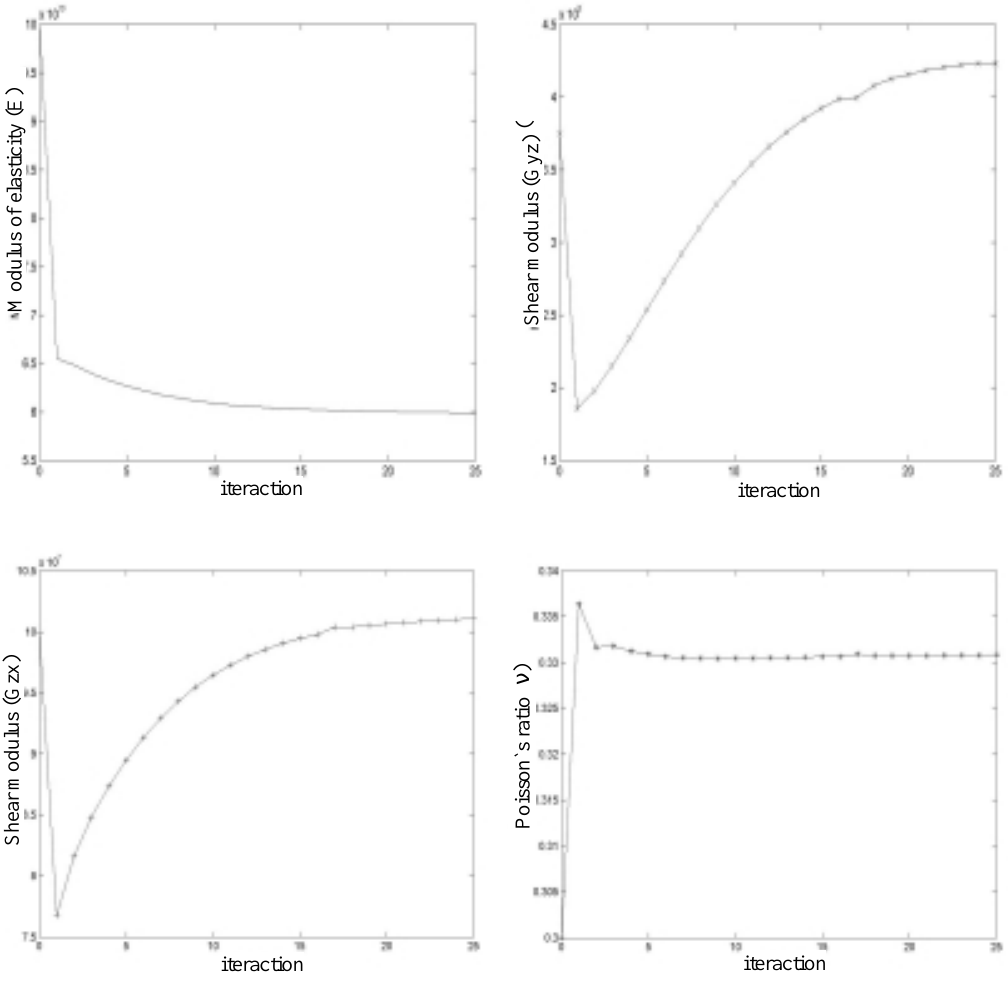
Fig. 5. Parameters evolution along the iterative